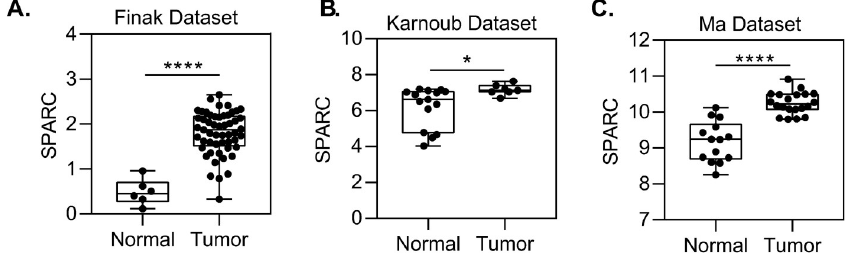
Fig 9. SPARC expression is upregulated in the tumor microenvironment. Stromal gene expression of SPARC in normal or breast cancer patients from (A) Finak et al, (B) Karnoub et al, or (C) Ma et al. � p < 0.05, ��� p < 0.001, ���� p <